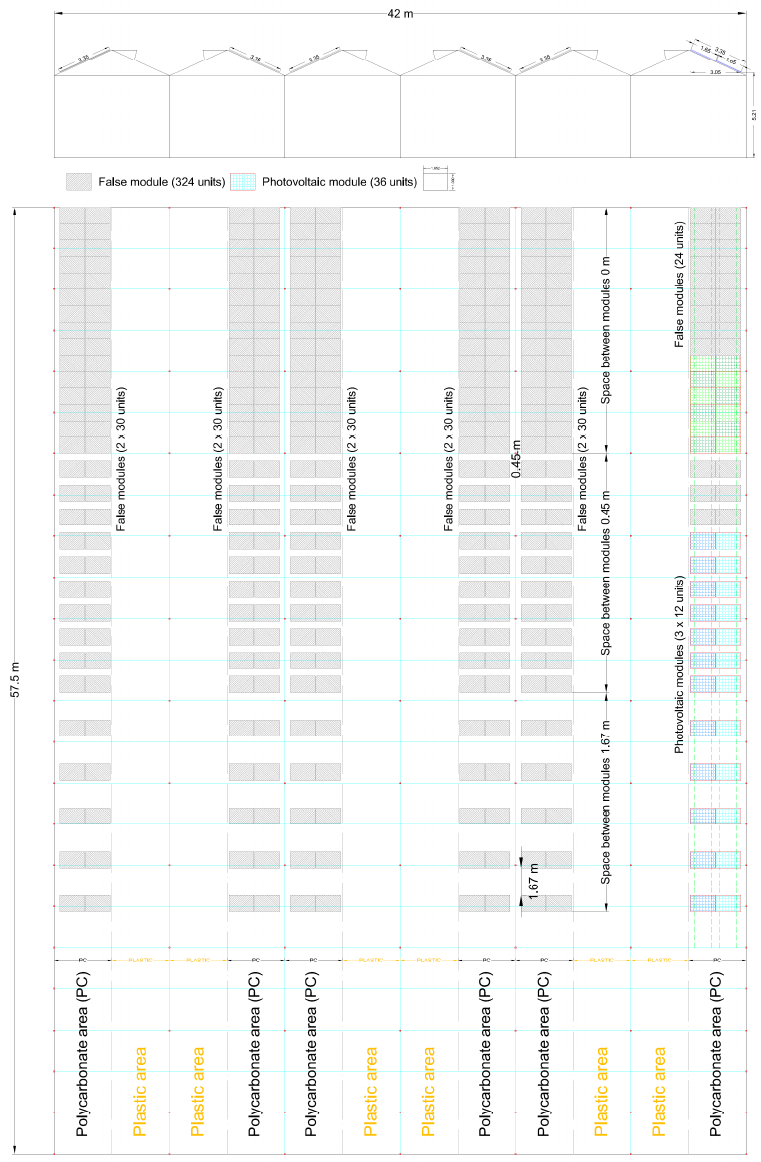
Figure 1. The photovoltaic panels and opaque polyethylene sheets location in the greenhouse rooftop.